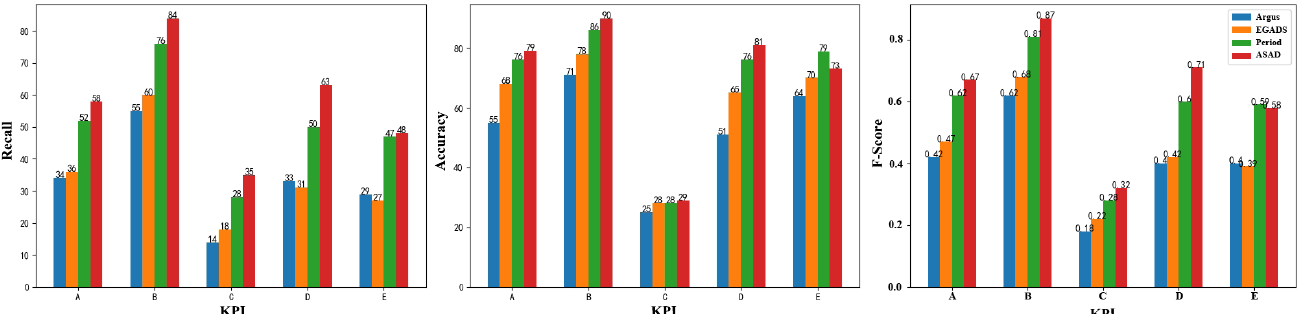
Figure 12. Experimental comparison to other